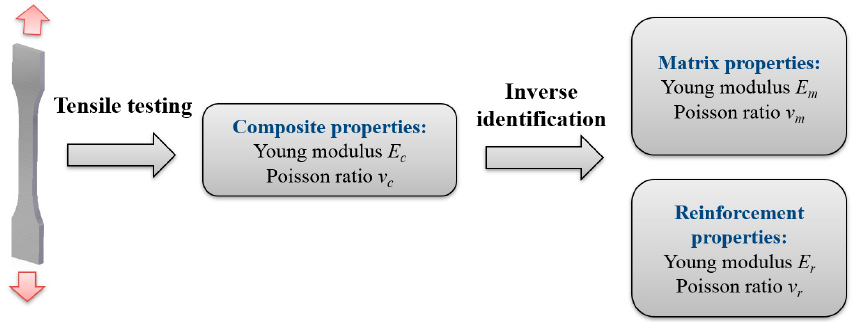
Figure 1. Simplified scheme presenting the idea of identification.